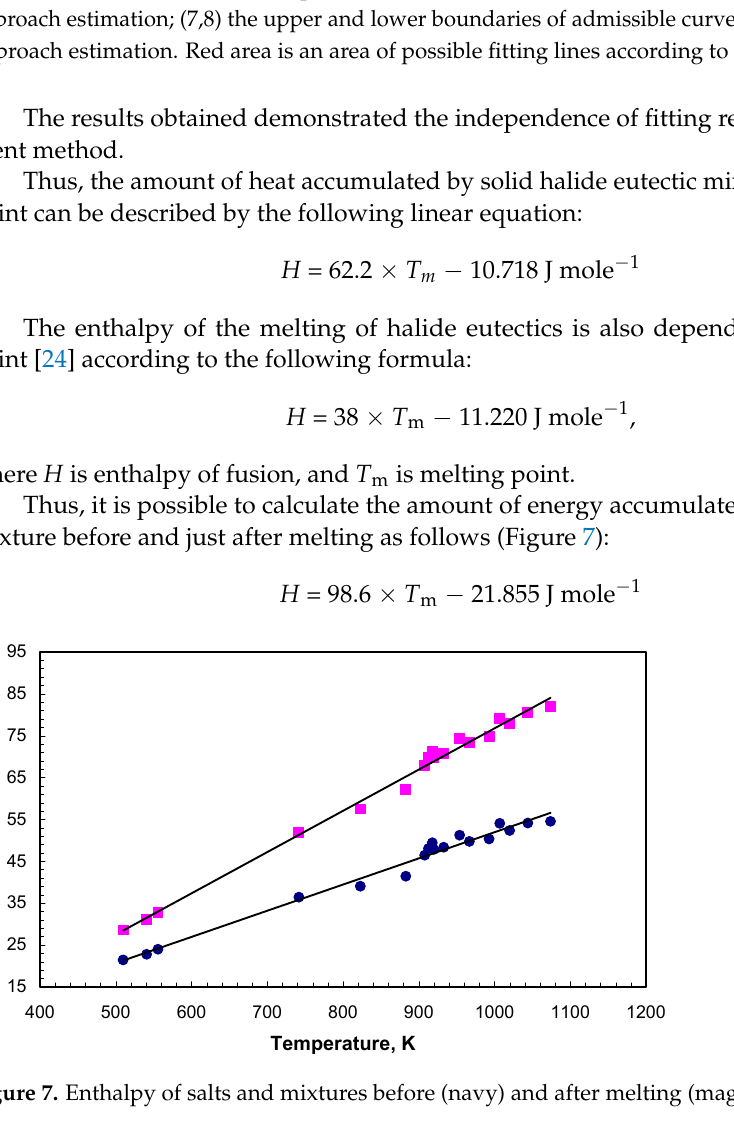
Figure 6. Input data and results of their processing.(1) measurements; (2) uncertainty interval H n of each measurement; (3) line of the LSQM—approximation; (4,5) boundaries “+2 σ ” and “–2 σ ” of the LSQM—admissible curves of the process; (6) the tube of admissible curves according to the interval approach estimation; (7,8) the upper and lower boundaries of admissible curves according to interval approach estimation. Red area is an area of possible fitting lines according to interval analysis.